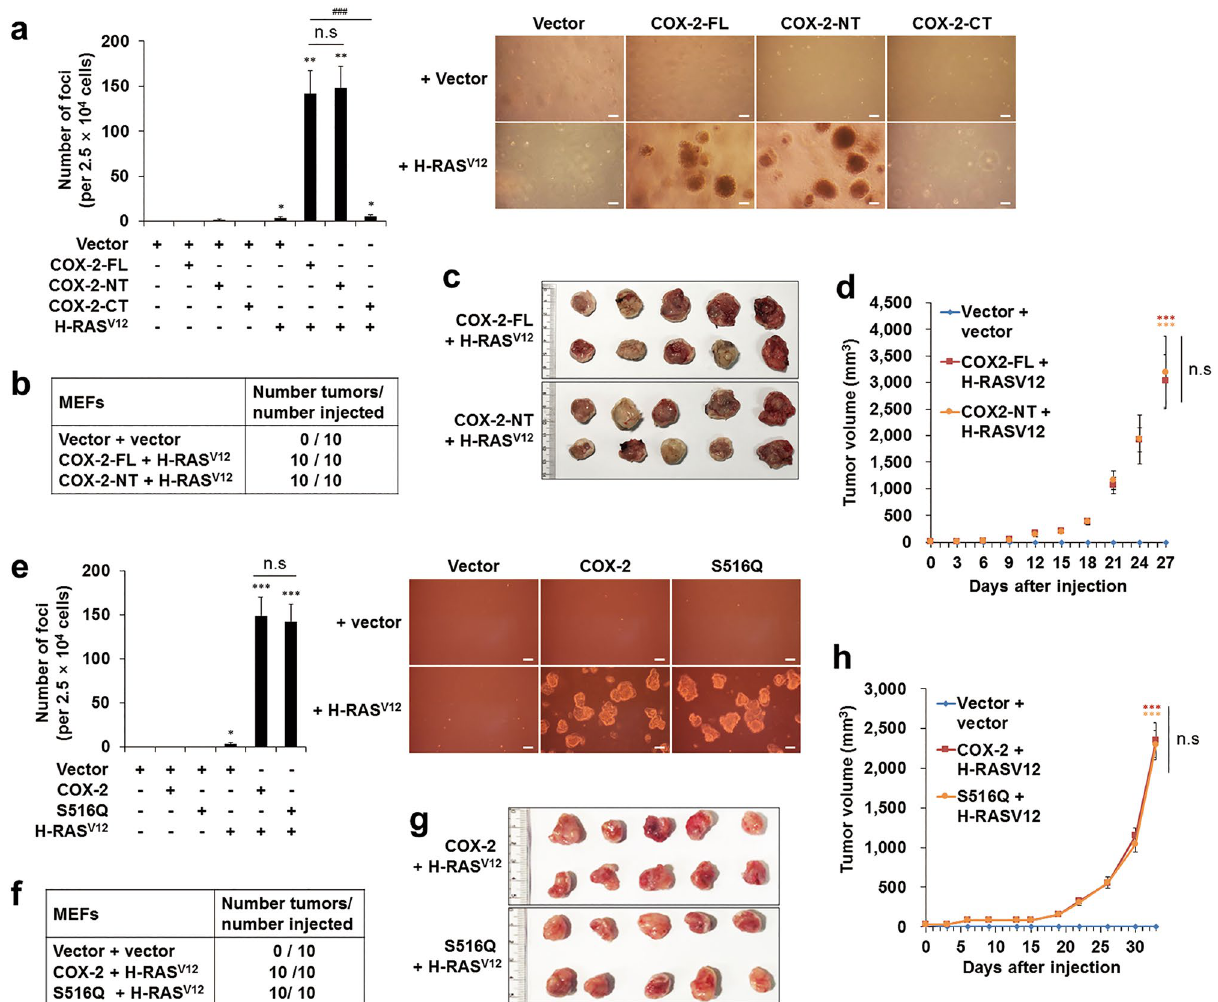
Figure 7. The COX-2-p53 interaction, not the catalytic activity, is involved in the COX-2-mediated neoplastic transformation. ( a , e ) Soft agar assay. MEFs were infected with retroviruses as indicated. Cells were seeded on the soft agar and the number of foci was counted (left). Representative data were shown (right). Data represent means ± SE ( n = 8; * P < 0.05, ** P < 0.01, *** P < 0.001 vs. Vector; ### P < 0.001; n.s, not significant). Scale bars = 100 μm. ( b – d , f – h) In vivo tumor formation assay. MEFs were infected with retroviruses as indicated and injected into nude mice. Total number of tumors per group ( b , f ), resected tumors ( c , g ) and tumor volumes ( d , h ) were shown. Data represent means ± SE in ( d ) and SD in ( h ) ( n = 10; *** P < 0.001 versus Vector + vector; n.s, not significant at the final